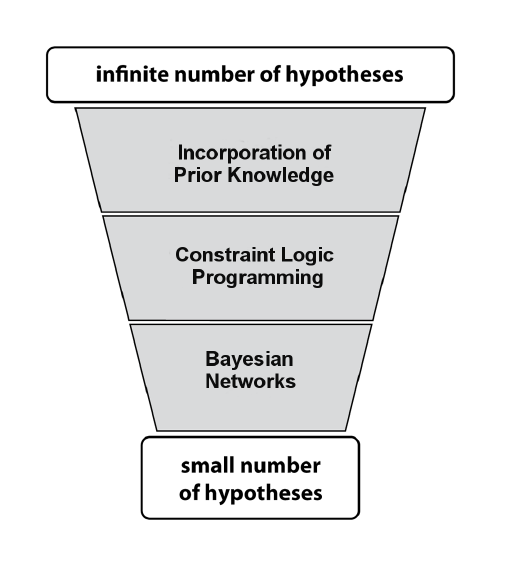
Figure 1: Our reasoning process restricts the space of hypothe- ses in three reasoning steps: incorporation of prior knowledge, Constraint Logic Programming and Bayesian